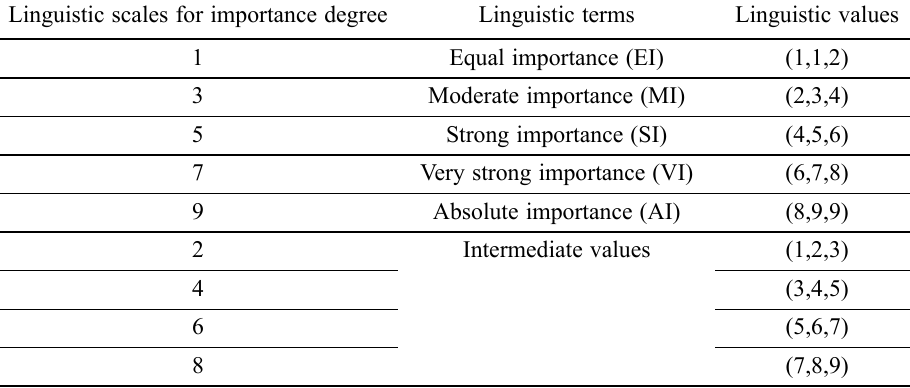
Table 1. Linguistic scales for the importance weight